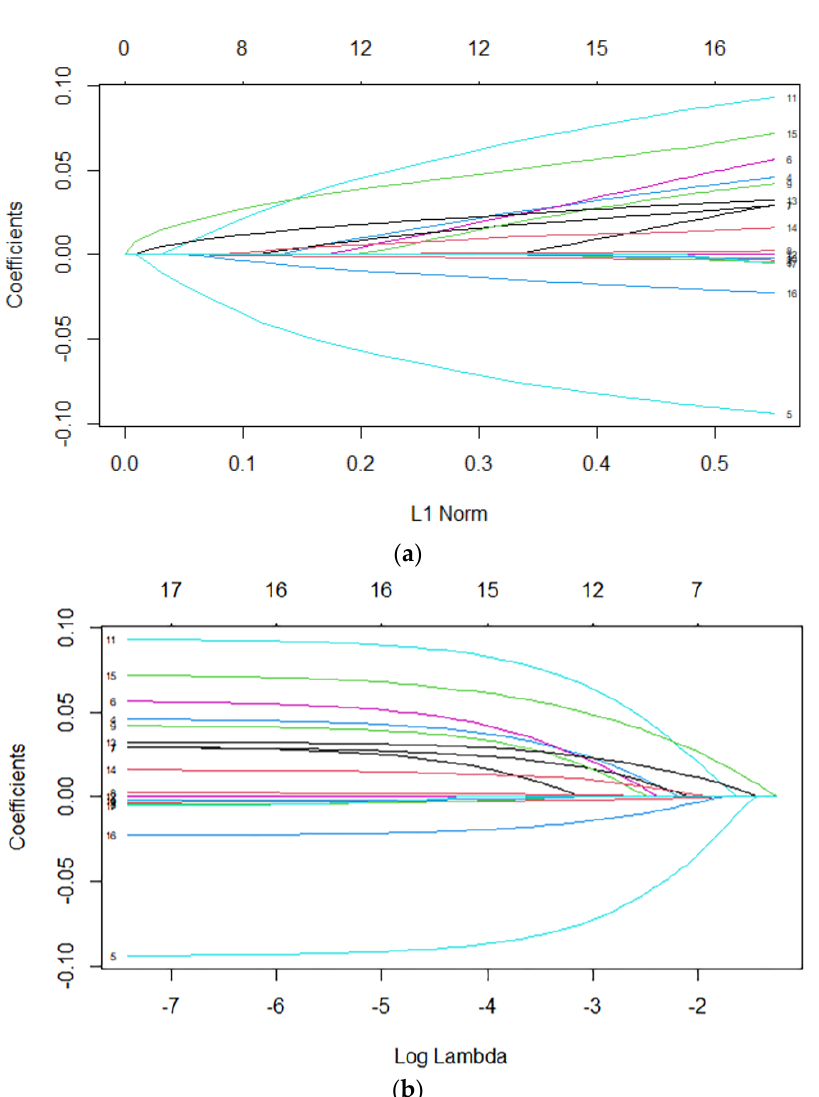
Figure 1. The coefficient path of the willingness to maintain the SLCP. ( a ) the coefficient path for the selected variables as a function of the norm. ( b ) the coefficient path for the selected variables as a function of λ .